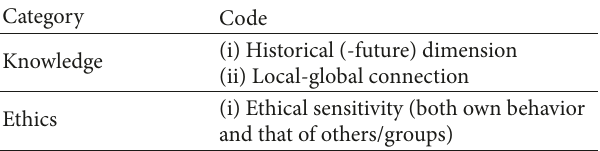
Table 4: Overview of codes for each category SQ2.